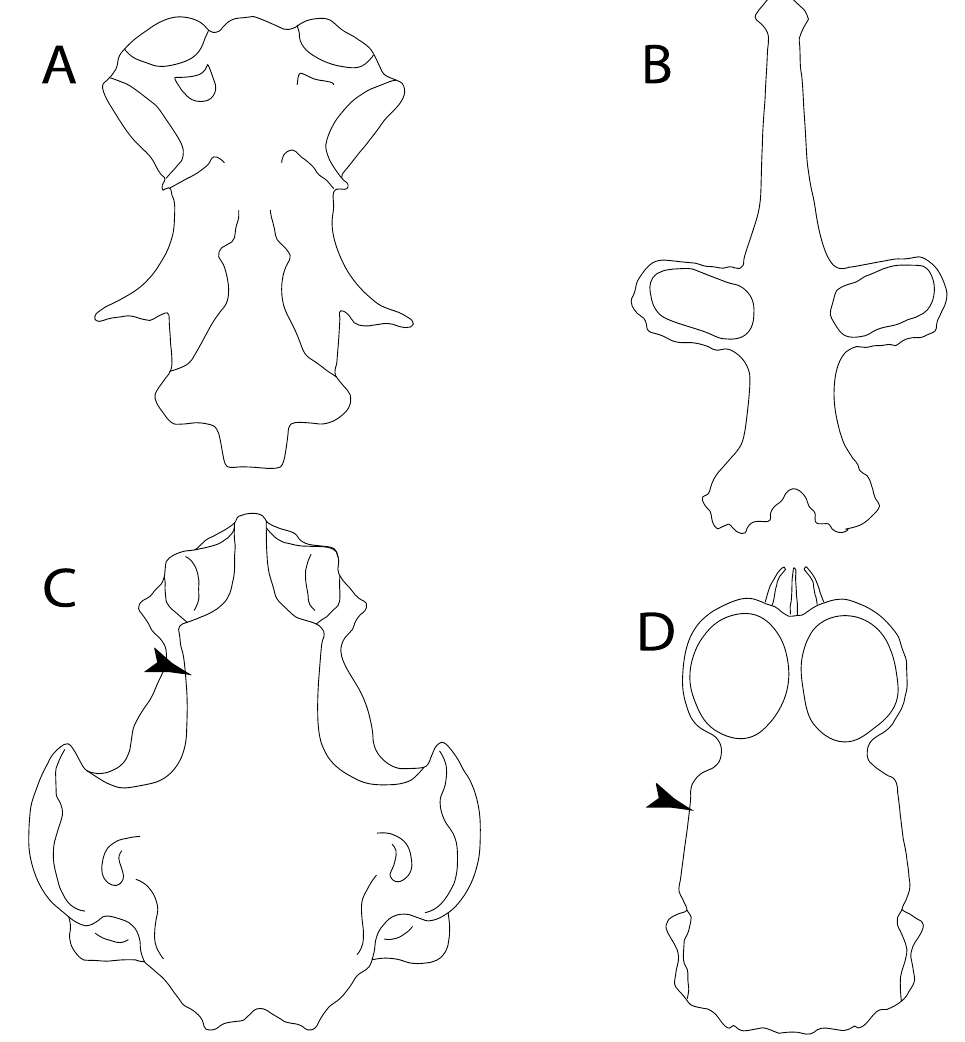
Figure 19. Interpretative drawings of the neurocranium in ventral view. State (0): ( A ) Hexanchus nakamurai (DAE 881504) redrawn and modified from Ebert et al. Text-Figure 8B in [89]; ( B ) Glaucostegus granulatus (NHMUK 2012.2.8.54). State (1): ( C ) † Hybodus († Egertonodus ) basanus redrawn and modified from Maisey Text-Figure 9B in [85]; ( D ) Scyliorhinus cabofriensis (UERJ 2231.4) redrawn from Soares et al. Text-Figure 7B in [87]. Arrowhead: suborbital shelf. 41. Basitrabecular process: (0) Absent, (1) present. Based on de Carvalho [38] (char. 11),